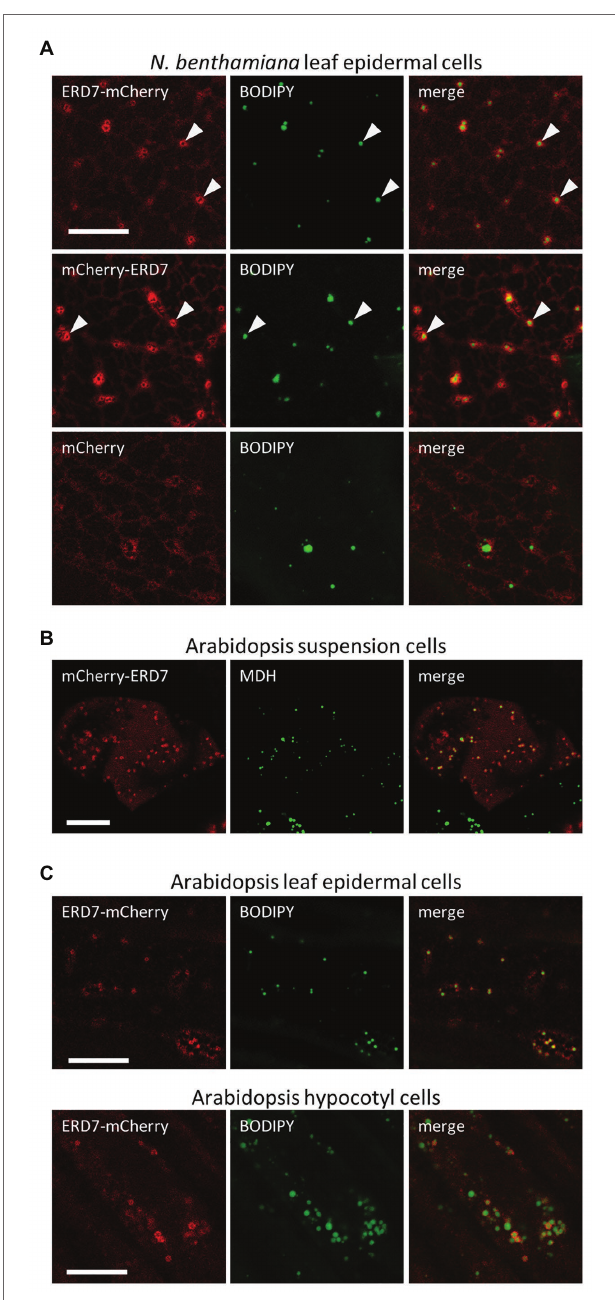
FIGURE 1 | Subcellular localization of EARLY RESPONSIVE TO DEHYDRATION 7 (ERD7) in plant cells. Representative confocal laser- scanning microscopy (CLSM) images (z-sections) of either (A) Agrobacterium - infiltrated Nicotiana benthamiana leaf epidermal cells, (B) biolistically- bombarded Arabidopsis suspension-cultured cells, or (C) transgenic Arabidopsis seedling leaf epidermal and hypocotyl cells, transiently- or stably- transformed with ERD7-mCherry, mCherry-ERD7, or mCherry alone (as indicated by the panel labels), and stained with the neutral lipid dyes BODIPY or MDH (false-colored green). Also shown for each set of images is the corresponding merged image. Arrowheads in the top two rows in (A) indicate obvious examples of mCherry-ERD7 and ERD7-mCherry fluorescence patterns surrounding the BODIPY-stained TAG core, indicating that ERD7 localizes to the surface of LDs. Scale bars in (A–C) = 10 μ